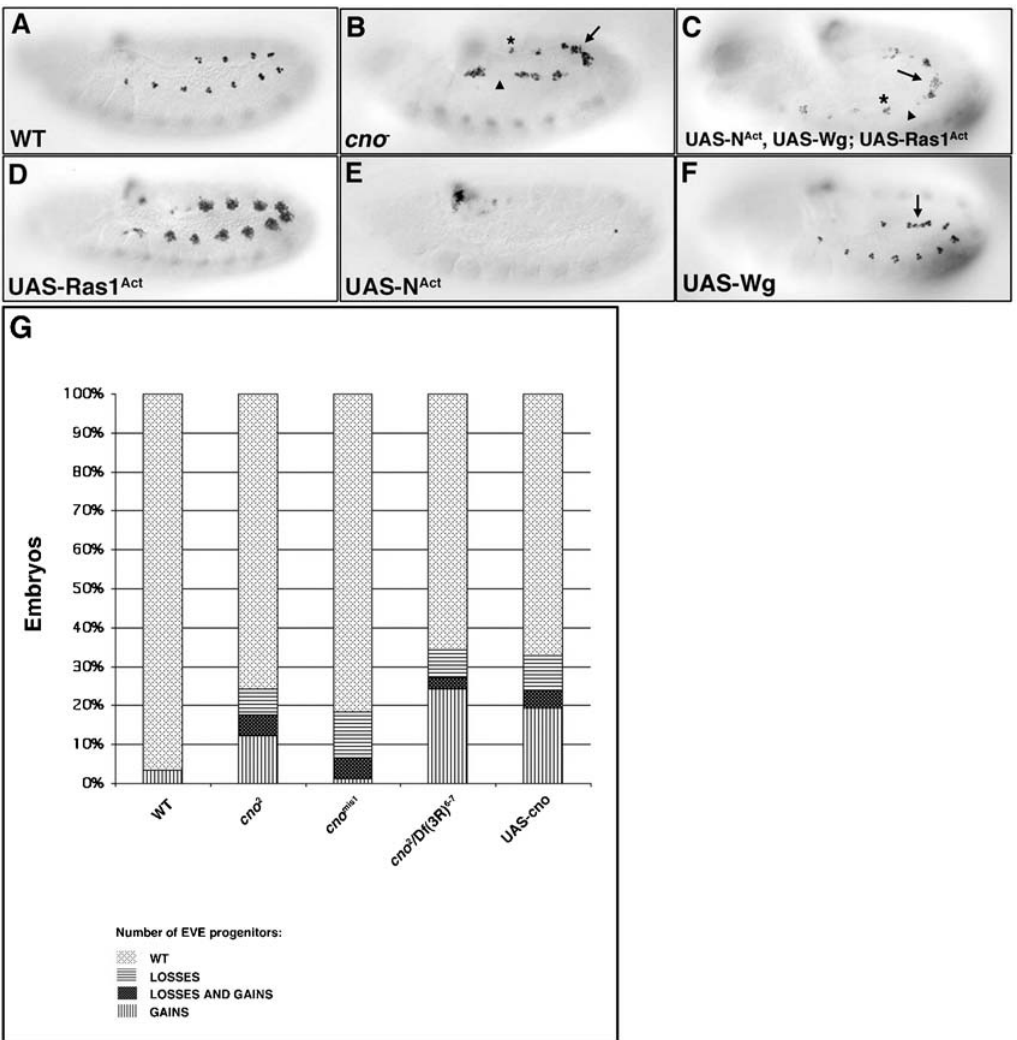
Figure 2. cno 2 zygotic null mutants display gain and loss of progenitors. All panels show lateral views of stage 11 embryos stained with an a -Eve antibody. (A) Eve wildtype (wt) expression in a subset of dorsal muscle/heart progenitors and founder cells (2–3 cells) per hemisegment. (B) cno 2 mutants show gain (arrow), loss (arrowhead) or a wildtype number (asterisk) of Eve + progenitors in different hemisegments. (C) Embryos in which N Act , Wg and Ras Act are simultaneously expressed in the mesoderm display a cno 2 -like phenotype: gain (arrow), loss (arrowhead) and wildtype number of Eve + progenitors (asterisk). (D) Overexpression of Ras1 Act in the mesoderm induces the specification of extra Eve + progenitors. (E) Overexpression of N Act in the mesoderm inhibits Eve + progenitor specification. (F) Embryos in which Wg is overexpressed in the mesoderm show gain of Eve + progenitors in intersegmental regions (arrow). (G) Table shows % of embryos of the indicated genotype that display a wildtype number of Eve + progenitors, Eve + progenitors gain, loss and both (gain and loss). cno 2 and cno mis1 are null and hypomorph mutant alleles, respectively; Df(3R) 6-7 removes cno . cno gof phenotype ( UAS-cno ) is also variable. Legends for bars are shown below the table. At least 70 embryos of each genotype were counted. P , 0.0001 for all genotypes except for cno mis1